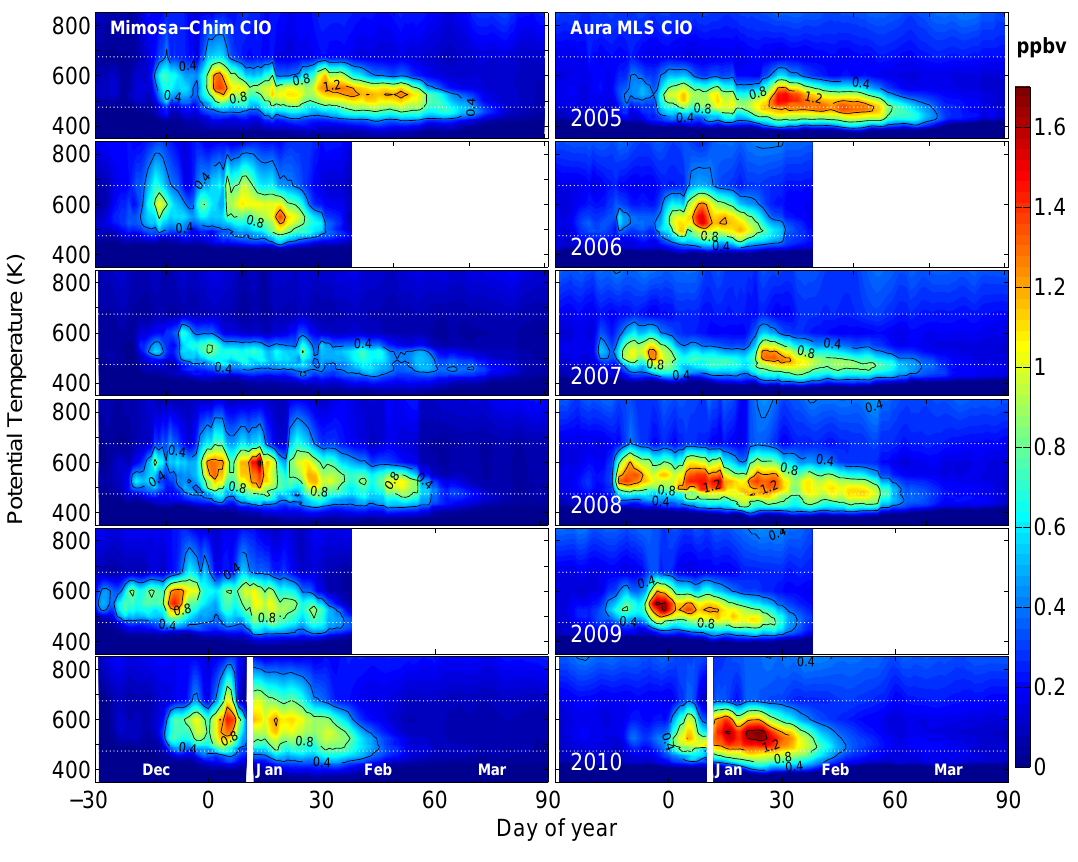
Fig. 5. Temporal evolution of the vertical distribution (350–850K) of vortex averaged ( ≥ 65 ◦ EqL) ClO (ppbv) for the Arctic winters 2005– 2010. Left: Mimosa-Chim calculations and Right: MLS measurements. The Model and MLS ClO coincident profiles are selected for solar zenith angles < 89 ◦ and local time between 10h and 16h. Both data are smoothed for three days. MLS ClO values are corrected for the negative bias identified by Santee et al.